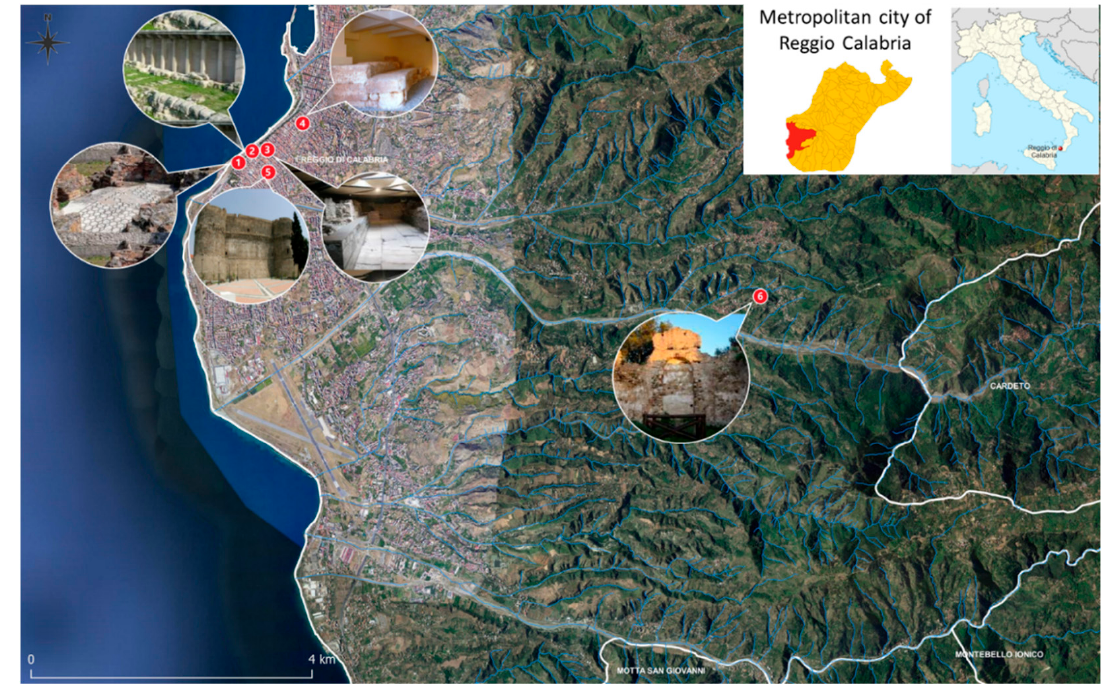
Figure 1. Location of areas: 1. Roman Thermae; 2. Greek Walls; 3. Piazza Italia; 4. Od é on; 5. Aragonese Castle; 6. Motta S.